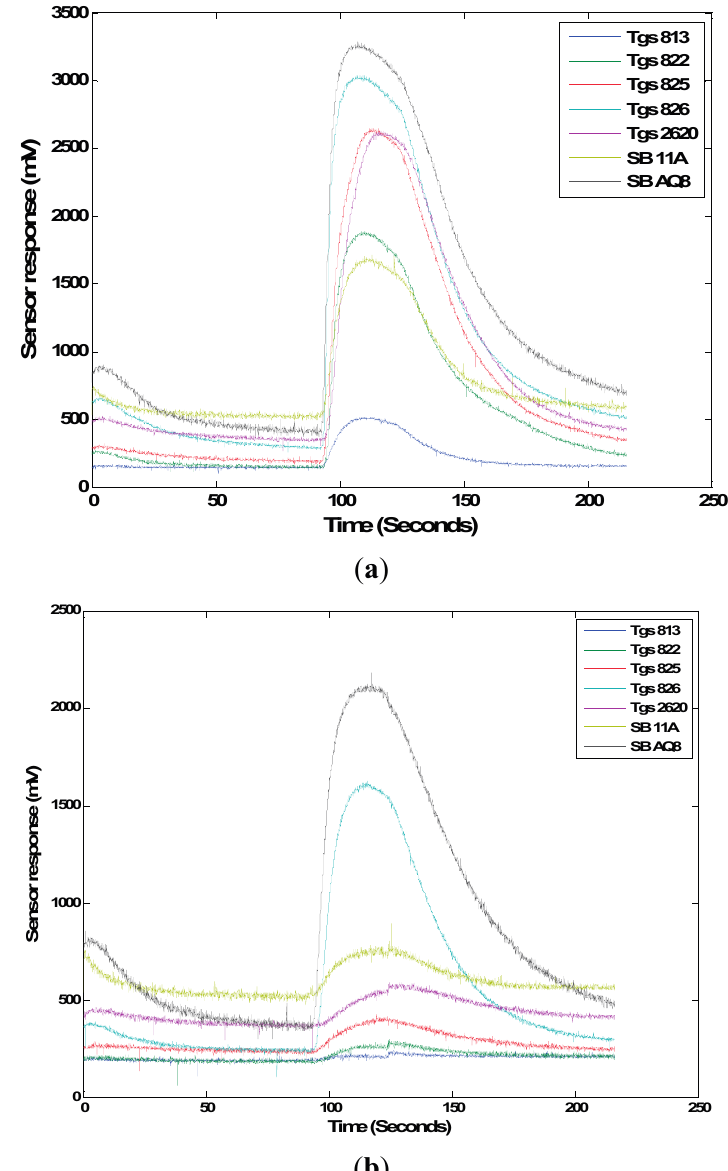
Figure 14. Response obtained from 7 MOS sensors to 0.5 μ L of methyl propyl disulfide ( a ); and 2-nonanone ( b